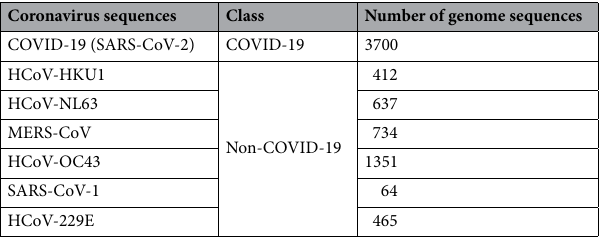
Table 2. Properties of human coronavirus